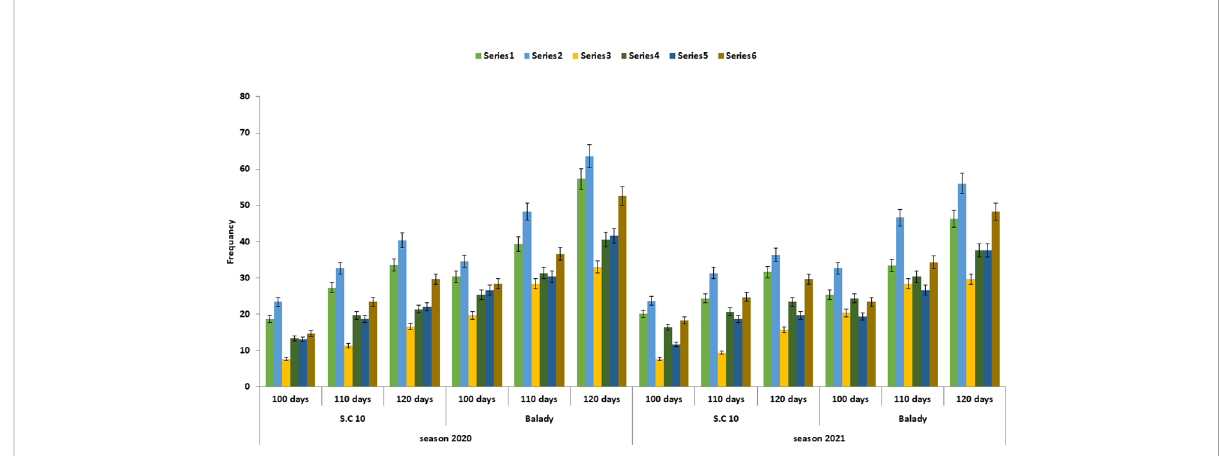
Our data (Table 10 and Figure 5) obtained during the 2020 growing season and at the fi nal harvest indicated that the insects infection % and lodging % were increased in the case of fresh animal manure (5-6 days old). This treatment increased insects